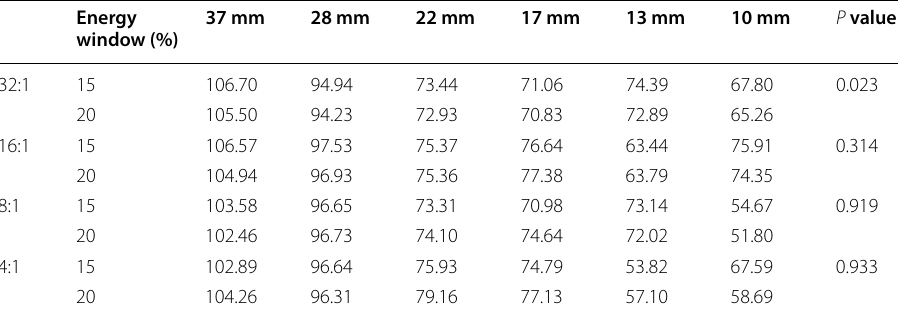
Reconstruction parameters: 35 iterations, 20 subsets, No filter; AC of acquisition